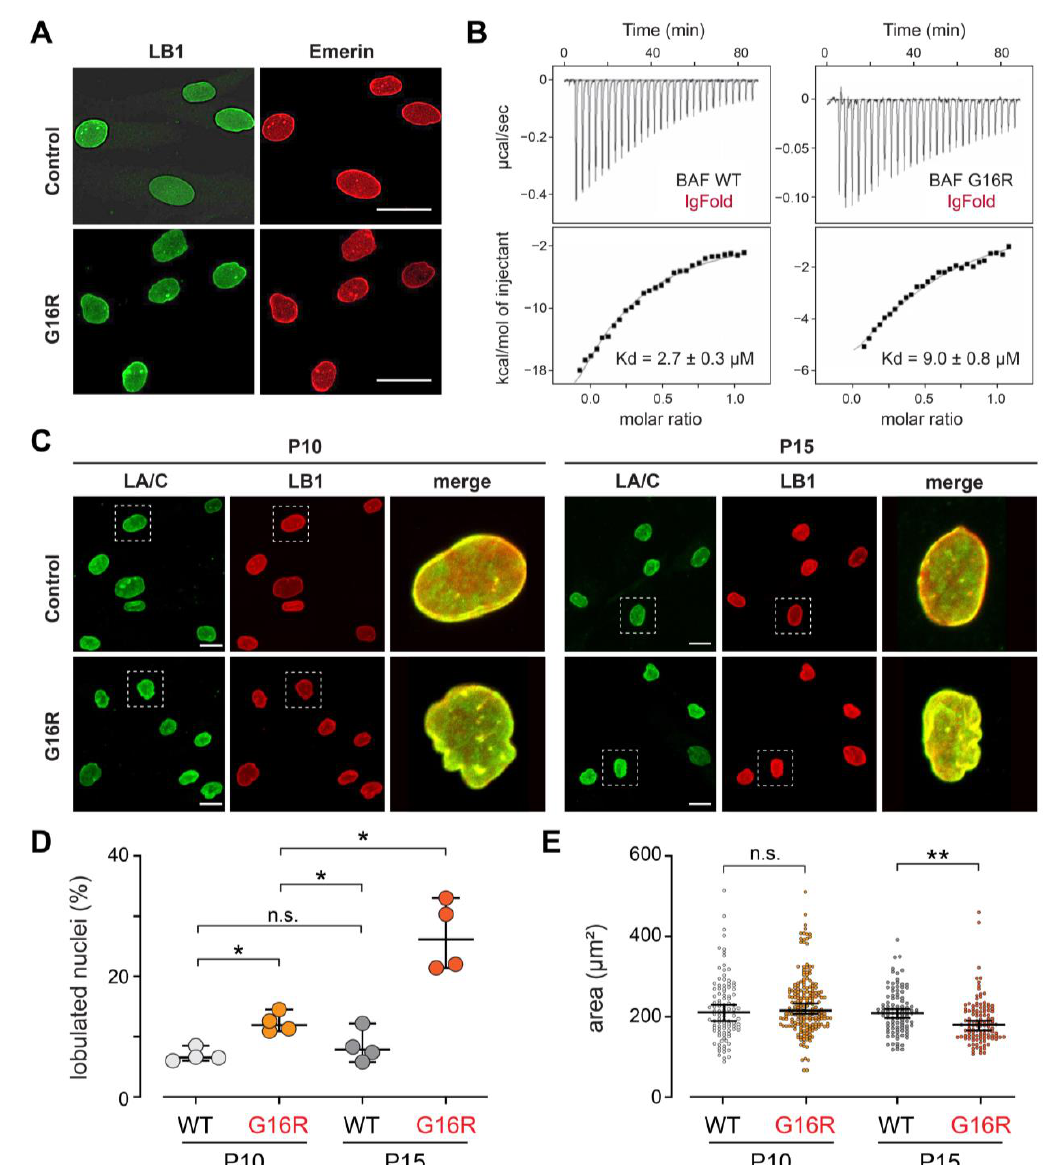
Figure 2. Reduced LA/C association with BAF Gly16Arg confers modest nuclear shape changes. ( A ) Confocal microscope images of control and patient passage 10 fibroblasts stained for lamin B1 (LB1; green) and emerin (red). Scale bars are 20 µm. ( B ) ITC titration analyses providing the affinity of BAF WT and BAF Gly16Arg for the lamin A/C IgFold domain. The experiment was repeated twice, and the dissociation constants represent the mean values calculated from these experiments (see Supplementary Figure S2). ( C ) Confocal microscope images of control and patient passage 10 and 15 fibroblasts stained for lamin A/C (LA/C; green) and lamin B1 (LB1; red). An enlarged image of the boxed nucleus is shown on right hand side of panel. Scale bars are 20 µm. ( D , E ) Graphs of changes in ( D ) shape and ( E ) nuclear area at P10 and P15. For nuclear shape, nuclei were scored as lobulated if they contained >1 lobulation [42]. Determinations were made using a double-blind approach, followed by averaging four data sets. For each coverslip, 100 nuclei were scored. Averages were compared using the Mann – Whitney test for non-parametric data. * p < 0.05. For nuclear area, measurements were made on 100 nuclei plated on two independent coverslips using CellProfiler software [41]. Means were compared using the unpaired t -test. ns = not significant, ** p <